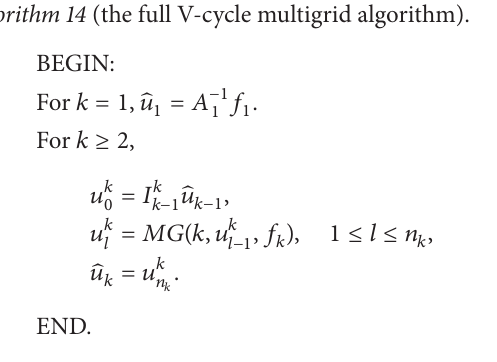
Algorithm 14 (the full V-cycle multigrid